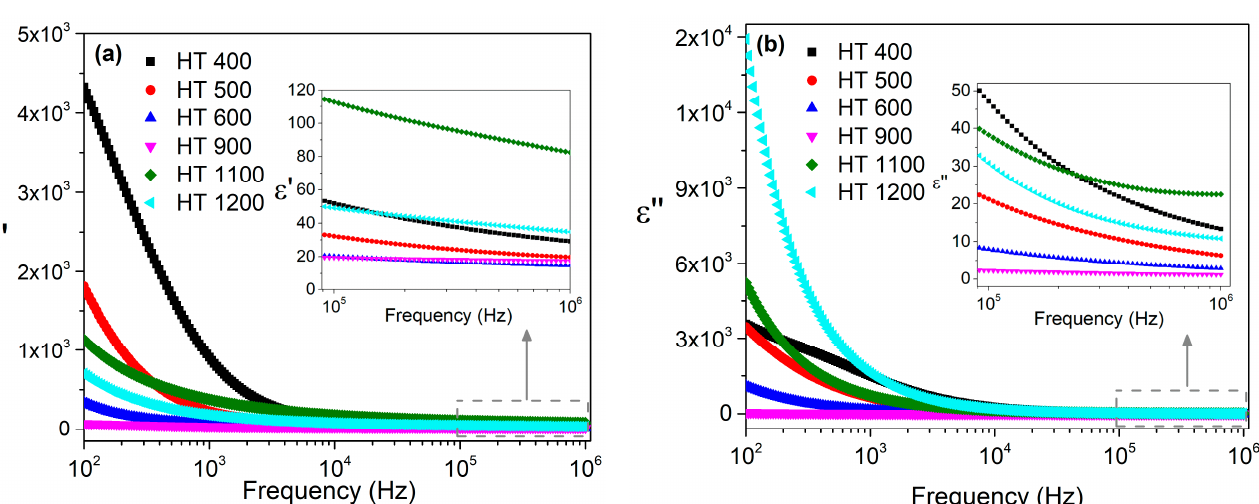
Table 2. Measured densities of the samples prepared via the colloidal gel and polymeric gel meth ‐ ods.